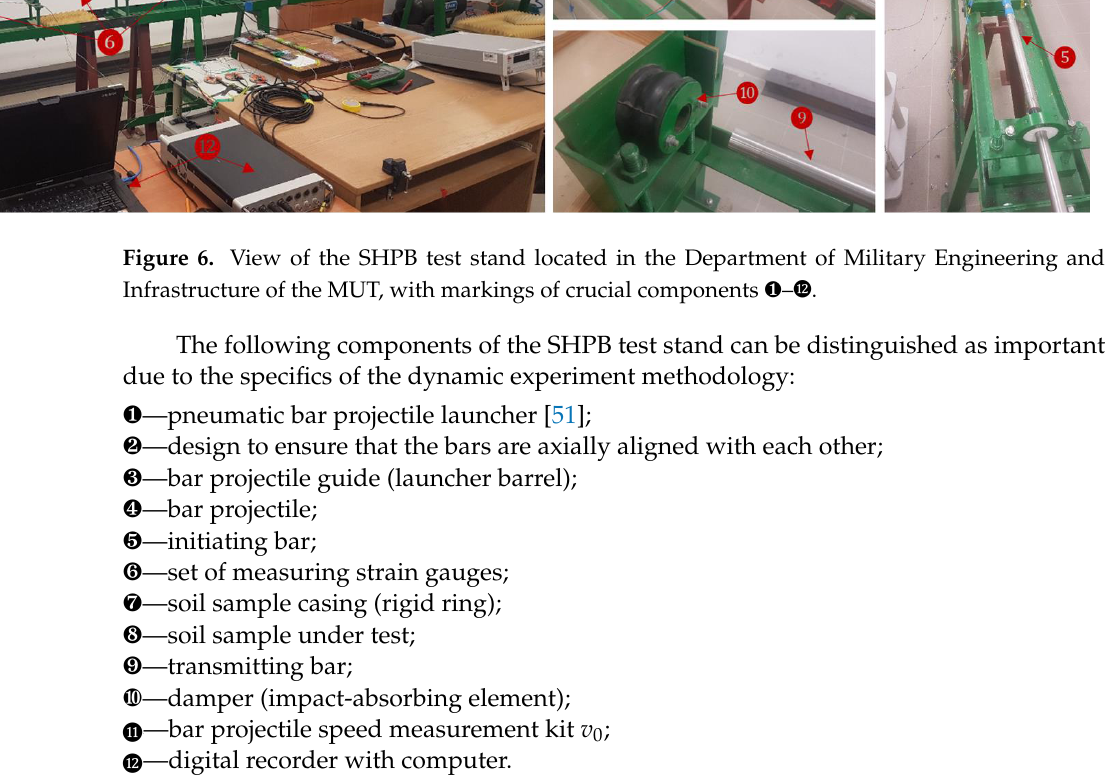
Figure 7. View of the Be tt ersizer S3 Plus laser particle size analyzer test stand located in the Depart- ment of Military Engineering and Infrastructure of the MUT, with markings of crucial components ① – ⑥.